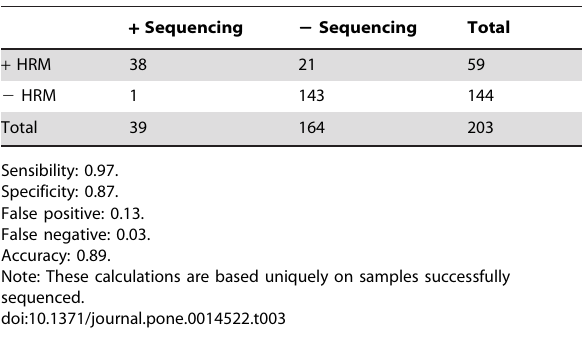
(distal region of exon 5, and exon 7) and GATA3 (proximal region of exon 6), affecting the comparison between sequence analysis